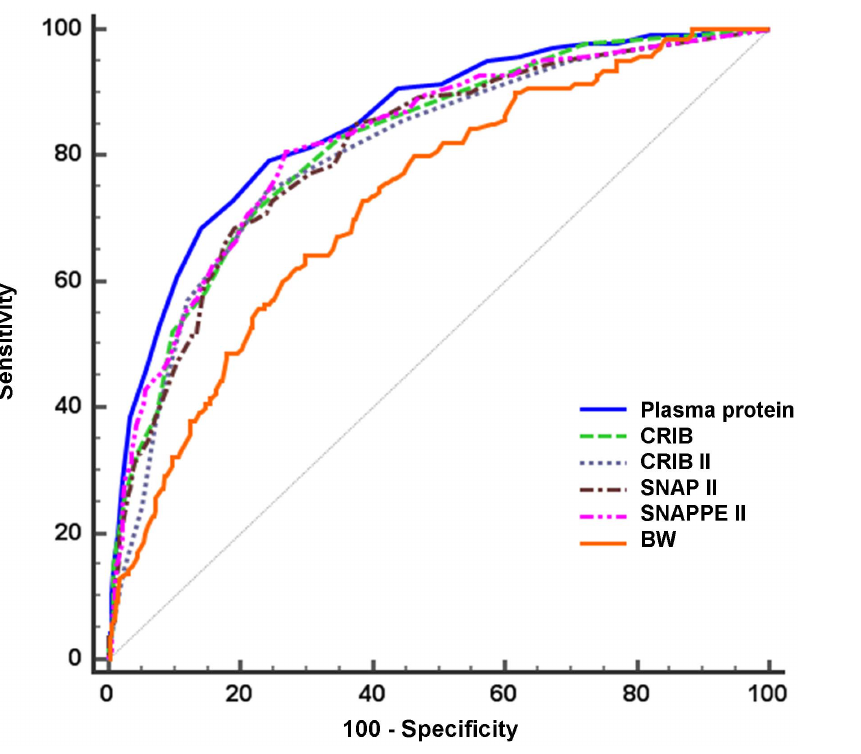
Figure 2. Receiver operating characteristic curves of plasma protein levels, CRIB, CRIB-II, SNAP-II, SNAPPE-II and birth weight (BW).